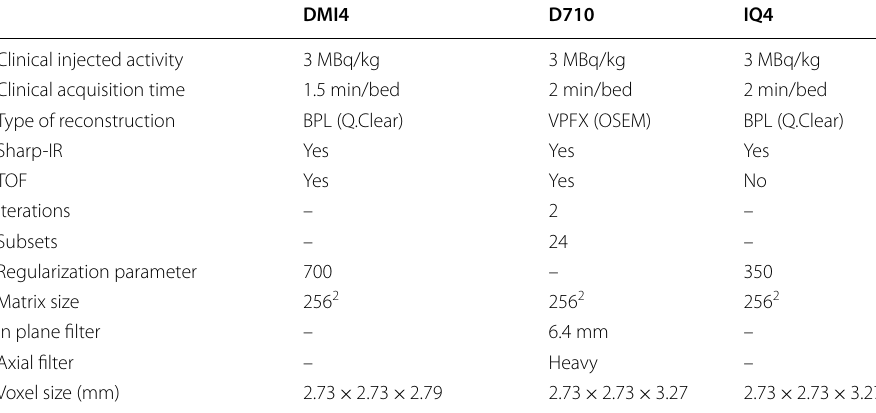
Table 1 Clinical acquisition and reconstruction set-up for the 3 PET